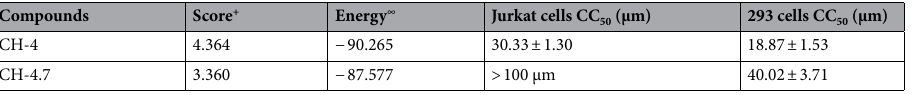
Table 2. SiMMap scores and docking energies for CH-4 and CH-4.7. The CC 50 value is presented as the mean ± standard deviation. + From SiMMap. ∞ From iGEMDOCK.